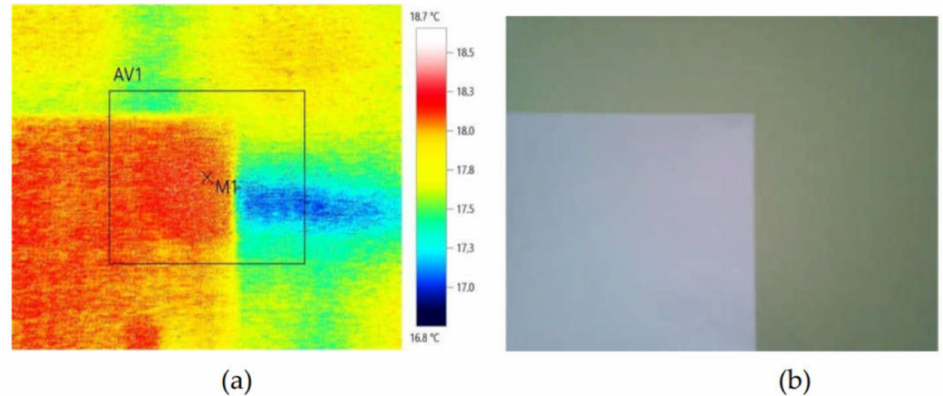
Figure 7. Temperature measurement of the wall from the inside using a thermographic camera ( a ) and the view of the wall and the white sheet of paper ( b